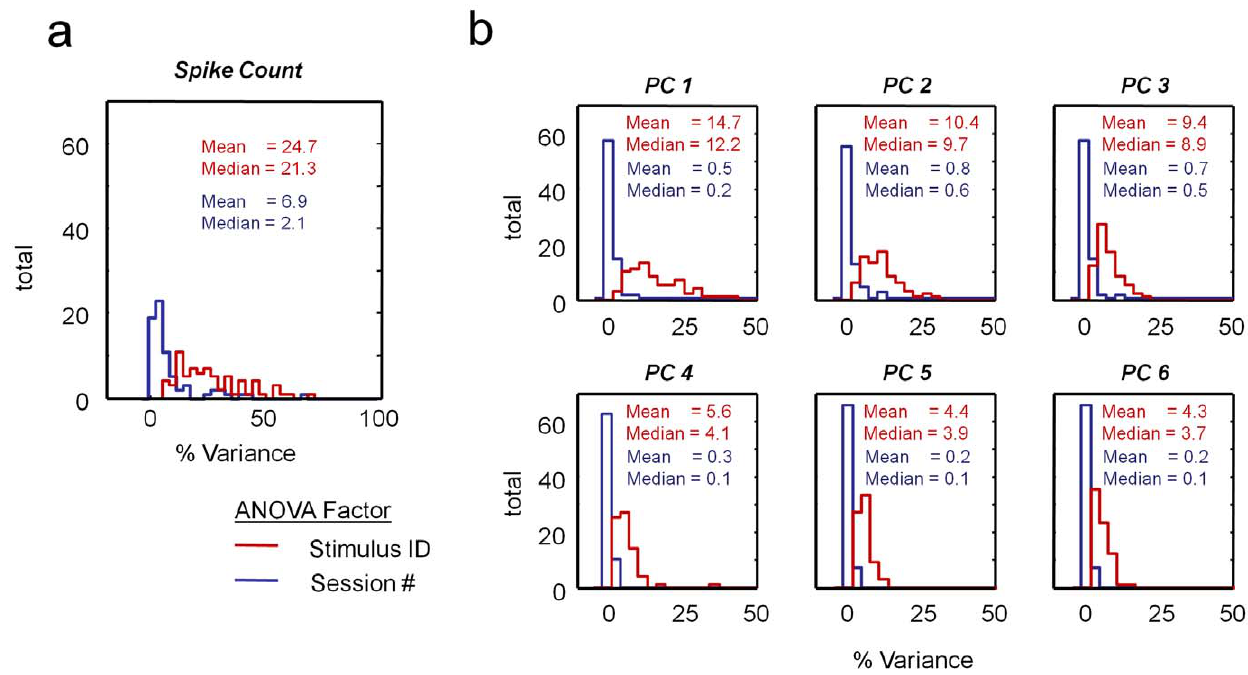
Figure 4. Comparison of variance attributed to stimulus selectivity vs. session number across the population of stably recorded neurons (N=72). A 2-way ANOVA was used to compute the percent variance attributed to these two factors. (a) Distribution of variance in the spike count (40 to 440 ms following stimulus onset) over stimulus and session. (b) Same analysis as (a), but for the variance in the coefficients of the first six principal components. Principal components were computed for each neuron individually based on the mean responses to the fifteen stimuli eliciting the highest responses. For each neuron, the coefficients corresponding to each trial were then computed as the inner product of the individual trial histogram with the first six principal components (see Methods ).